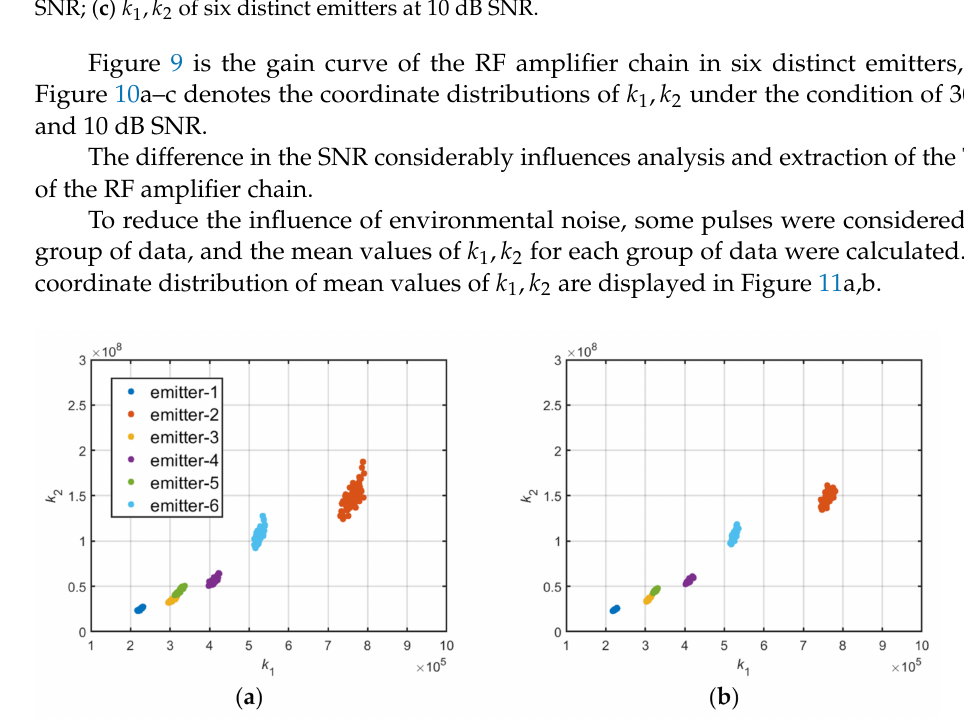
Figure 11. ( a ) Mean value of k 1 , k 2 of six distinct emitters at 10 dB SNR (10 pulses in each group); ( b ) mean value of k 1 , k 2 of six distinct emitters at 10 dB SNR (20 pulses in each